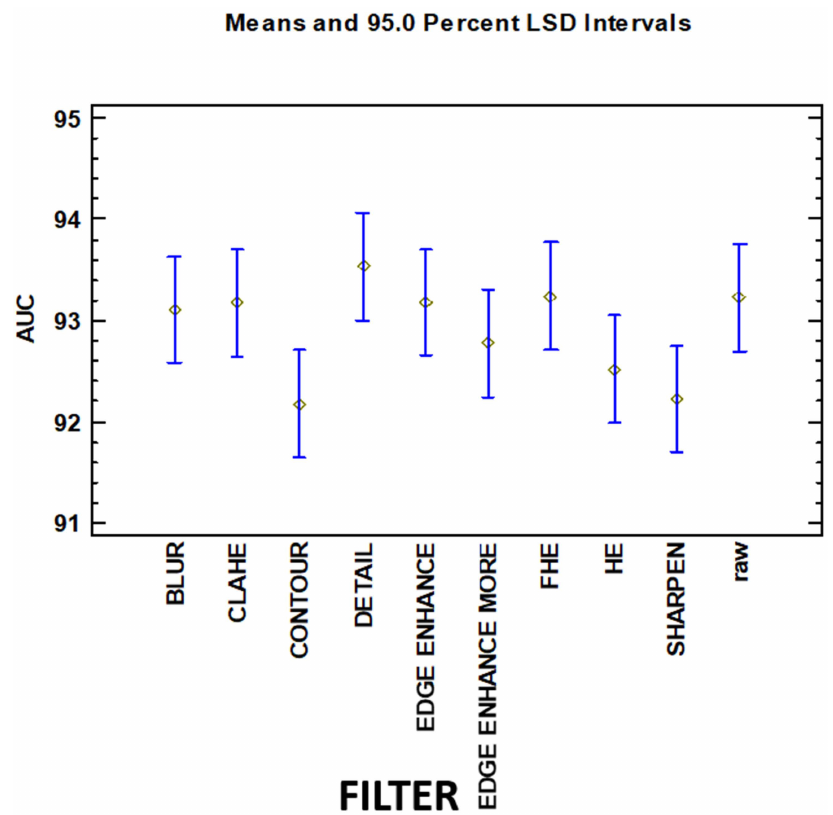
Figure 3. Multiple Range Tests for variable Filter.